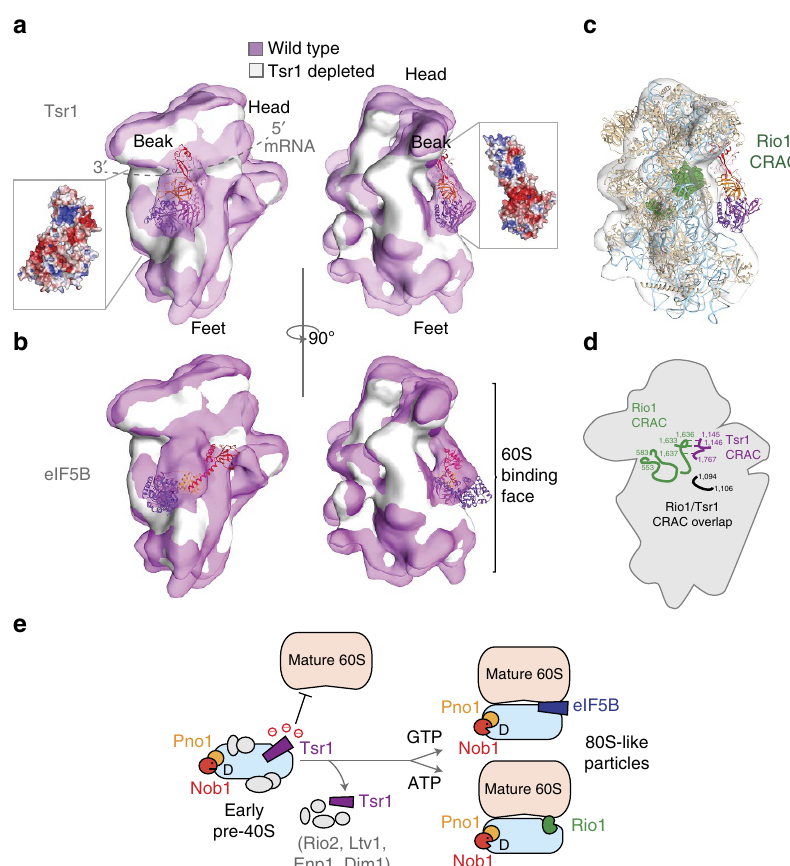
Figure 5 | Tsr1 excludes binding of eIF5B and Rio1. ( a ) The Tsr1 structure was fitted into aligned, previously published cryo-EM maps of pre-40S particles derived from wild-type (transparent magenta, EMD1926) and Tsr1-depleted (opaque white, EMD1927) yeast cells. The particle is viewed from the mRNA-binding surface (left) and a 90 (cid:2) rotation (right) to show the positioning of Tsr1 with respect to the 60S interaction surface. Tsr1 is shown with the front view rotated B 180 (cid:2) in the plane of the page with respect to Fig. 1c. Inset figures indicate the electrostatic surface of Tsr1 when fitted into the particle. ( b ) A 40S structure from a mammalian pre-initiation complex, including eIF5B (PDBID 4UJD), was fitted to EMD1926. Proteins, rRNA and tRNA from the pre-initiation complex are hidden, with the exception of eIF5B, for the sake of clarity. The orientations are as in a . The face of the 40S that interacts with the 60S is indicated with a bracket. ( c ) Side view of Tsr1 fitted to cryo-EM particles with 40S subunit from yeast fitted into the map (PDBID 4V8Y). Bases previously identified as Rio1 crosslinking sites by CRAC are coloured green and shown as space-fill. ( d ) Overview of the arrangement of Rio1 (green), Tsr1 (purple) and common (black) CRAC sites. ( e ) Tsr1 binding is mutually exclusive with binding of eIF5b and Rio1, and with 60S subunit joining. We speculate that negative charges on the surface of Tsr1 prevent premature 60S joining. Displacement of Tsr1, along with other early and intermediate pre-40S assembly factors (Rio2, Ltv1, Enp1 and Dim1), is required for late pre-40S maturation. Following removal of Tsr1, eIF5B-binding promotes GTP-dependent 60S subunit association, while Rio1 is predicted to promote ATP-dependent association. In both cases, formation of these 80S-like particles may constitute a quality control step, verifying that the pre-40S particle is close to the mature structure, before final 3 0 processing of the 18S rRNA by the endonuclease